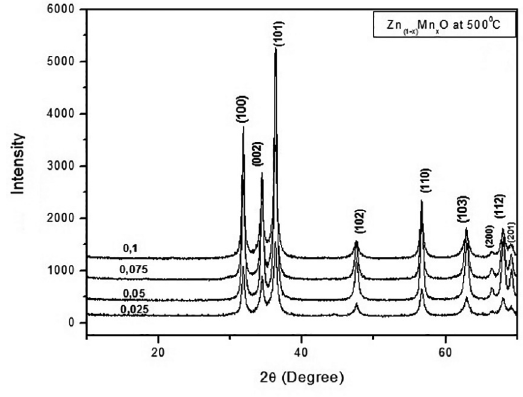
Figure 1: X-ray diffraction patterns for powders with different compositions of Zn